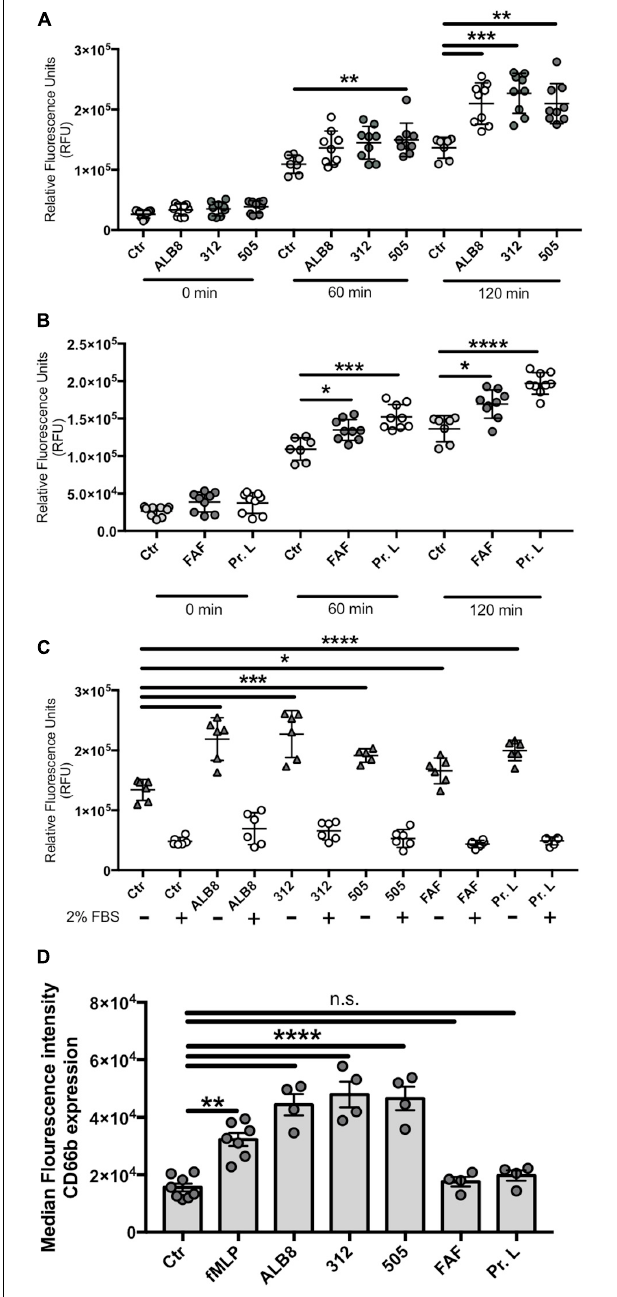
FIGURE 1 | Finegoldia magna bacteria and respective proteins activate neutrophils. Neutrophils were incubated with (A) heat inactivated F. magna strains ALB8, 312 or 505 or with (B) purified protein FAF and protein L. Production of ROS was measured every 60 min and is displayed as relative fluorescence units (RFU). (C) ROS production was measured in presence and absence of 2% FBS, which reduced all stimuli-triggered ROS production. Control (Ctr) represents unstimulated neutrophils. (D) Neutrophils incubated as above were analyzed by flow cytometry. The median fluorescence intensity indicates the CD66b surface expression on neutrophils in response to F. magna strains and purified proteins FAF and protein L. All data represent mean ± SEM of 3 independent experiments. * p ≤ 0.05, ** p ≤ 0.01, *** p ≤ 0.001, **** p ≤